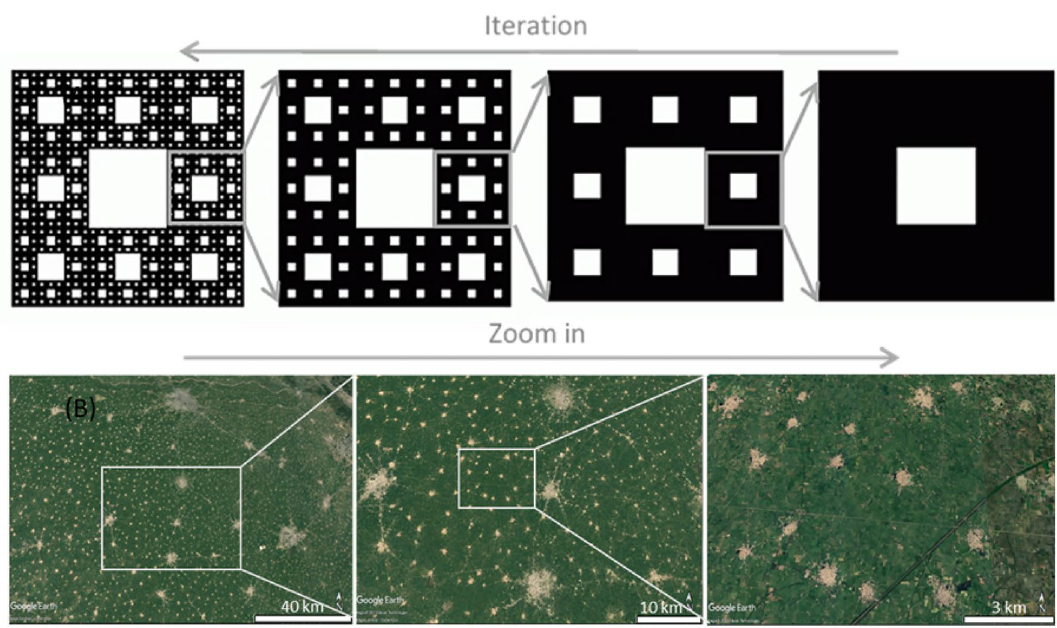
Figure 2. Self-similarity at different scales. ( A ) Sierpinski Carpet fractal pattern, generated from a binary, basic shape by three iterations. ( B ) Google Earth image of the settlement pattern in the Punjab region in 2018 at three levels of zooming-in (accessed from Google Earth Pro 7.1 on